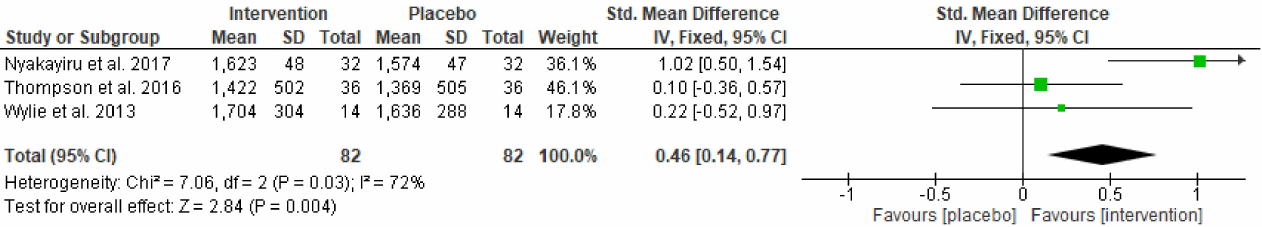
Figure 5. Forest plot comparing the effect of chronic beetroot supplementation on peak and mean power output.